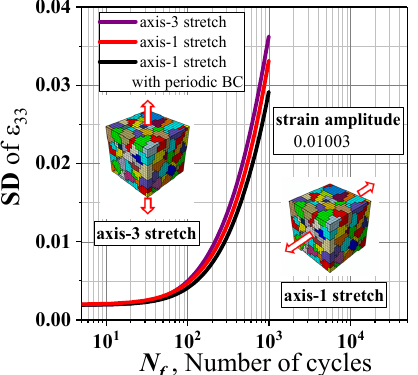
Figure 14. The curves of SD at strain amplitude 0.00601 vs. cycle number under different conditions: loading on axis-3 and on axis-1 and loading on axis-1 adopting periodic boundary